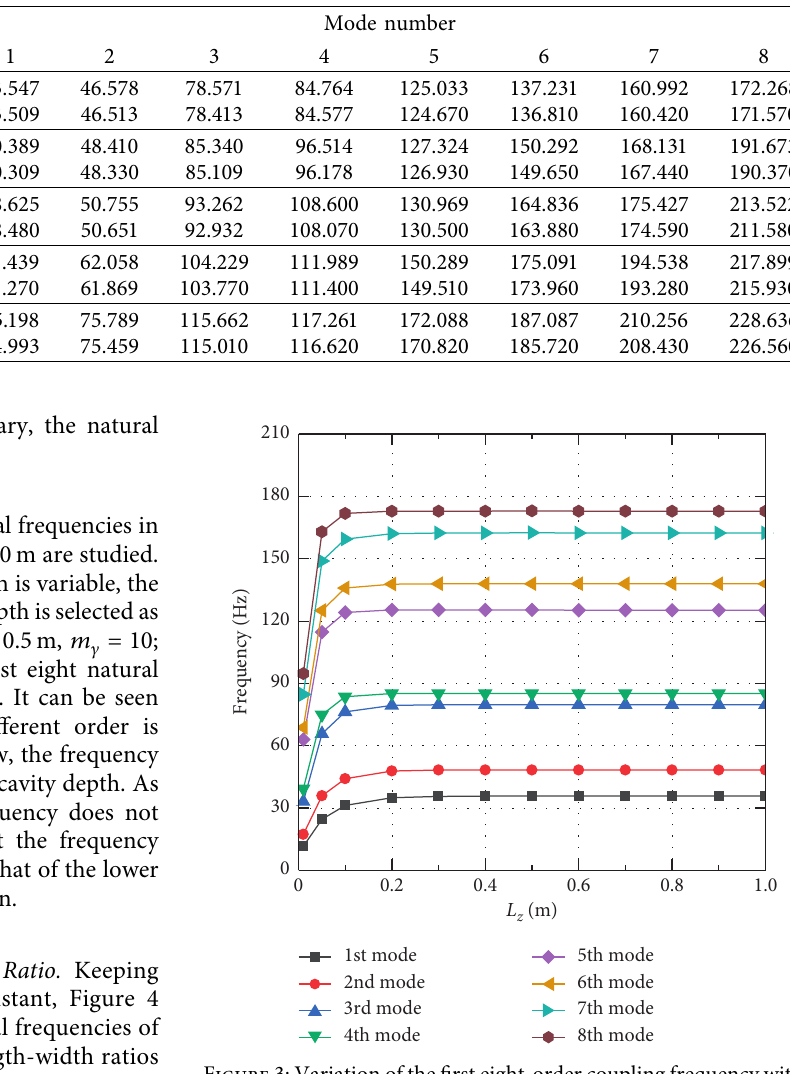
Table 3: Natural frequencies under different boundary conditions.